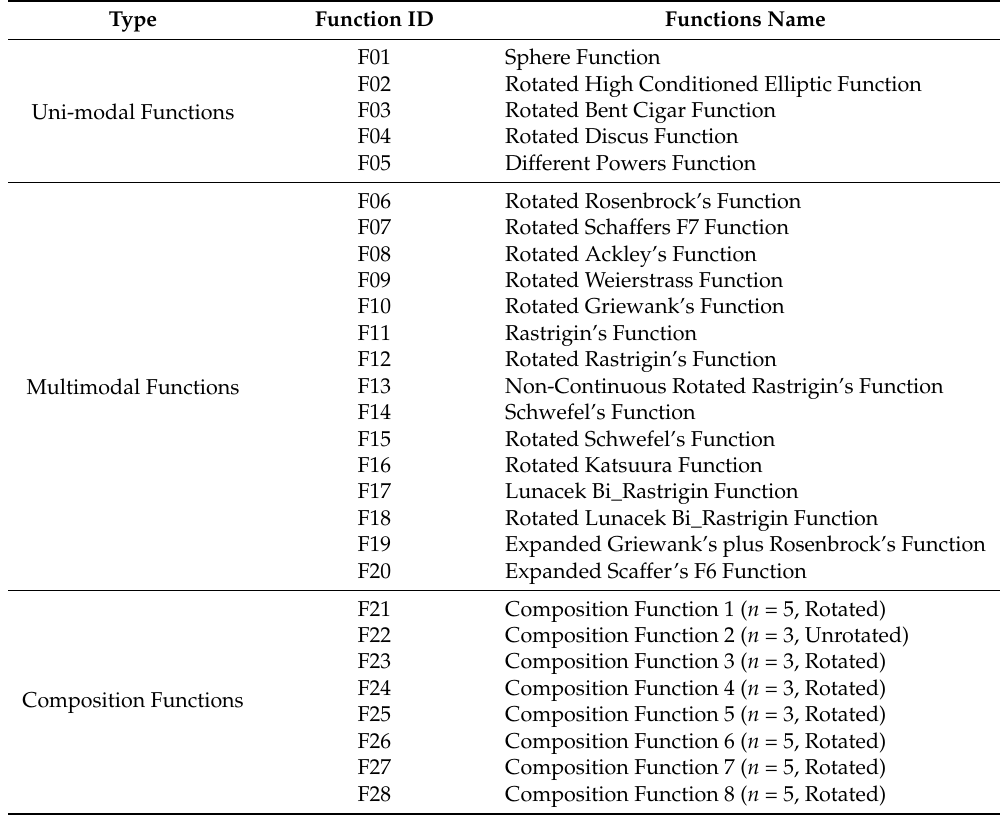
Table 4. Benchmark functions tested by PTBO (CEC2013).